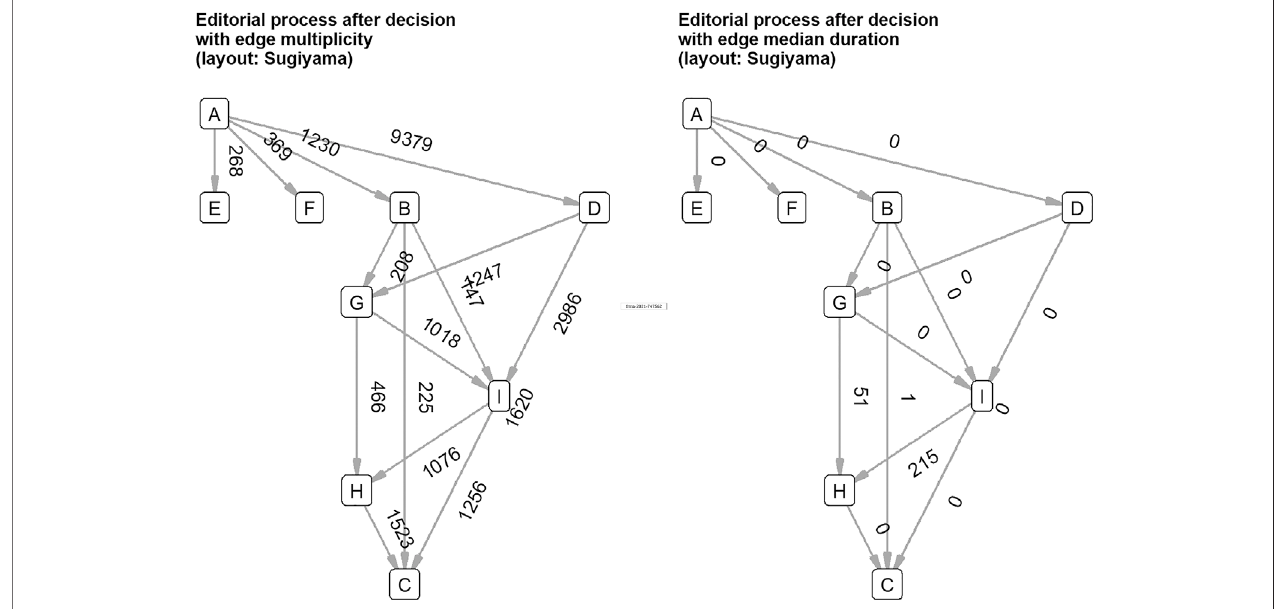
FIGURE 6 | Events after decision with multiplicity and median duration show that editors thoroughly communicate about negative decisions. A — Editor Decision Complete, B — Manuscript Revise and Re-Review, C — Waiting to Send Decision to Author, D — Manuscript Rejected, E — Manuscript Revise Only, F — Manuscript Accepted, G — Drafting Decision Letter Started, H — Drafting Decision Letter Completed, I — Manuscript Consultation Session